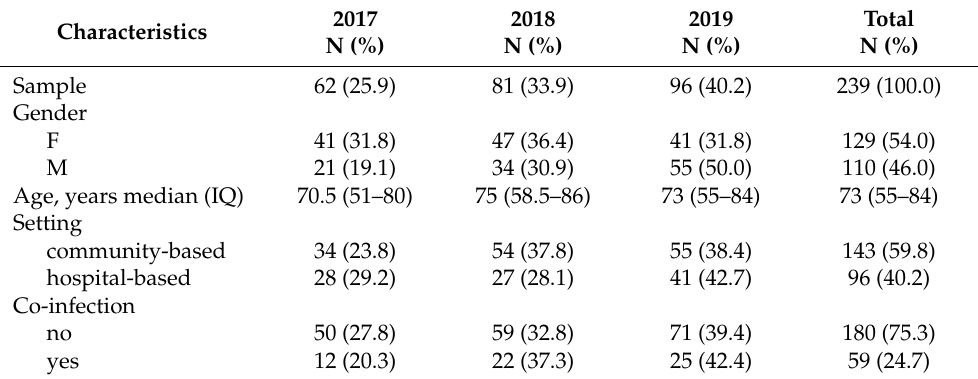
Table 1. Characteristics of the sample stratified by survey’s